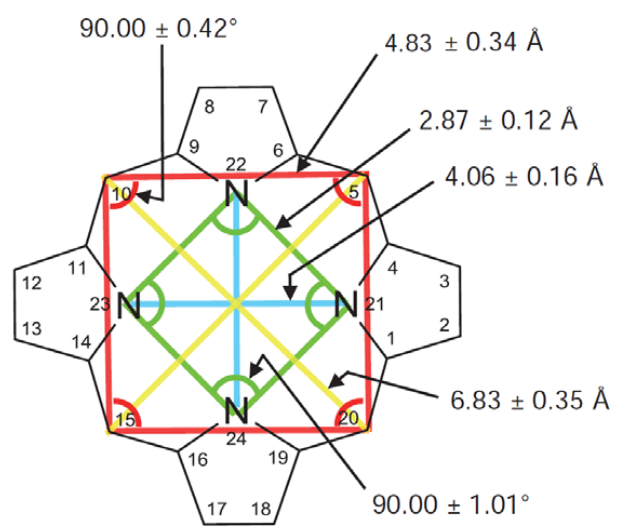
Figure 3. Mean bond distances and angles in the porphine macrocycle, after [10], with permission from World Scientific Publishing C.o. Note that the numbering system is the mirror image of that in Figure 2a, with the exception of the N positions.